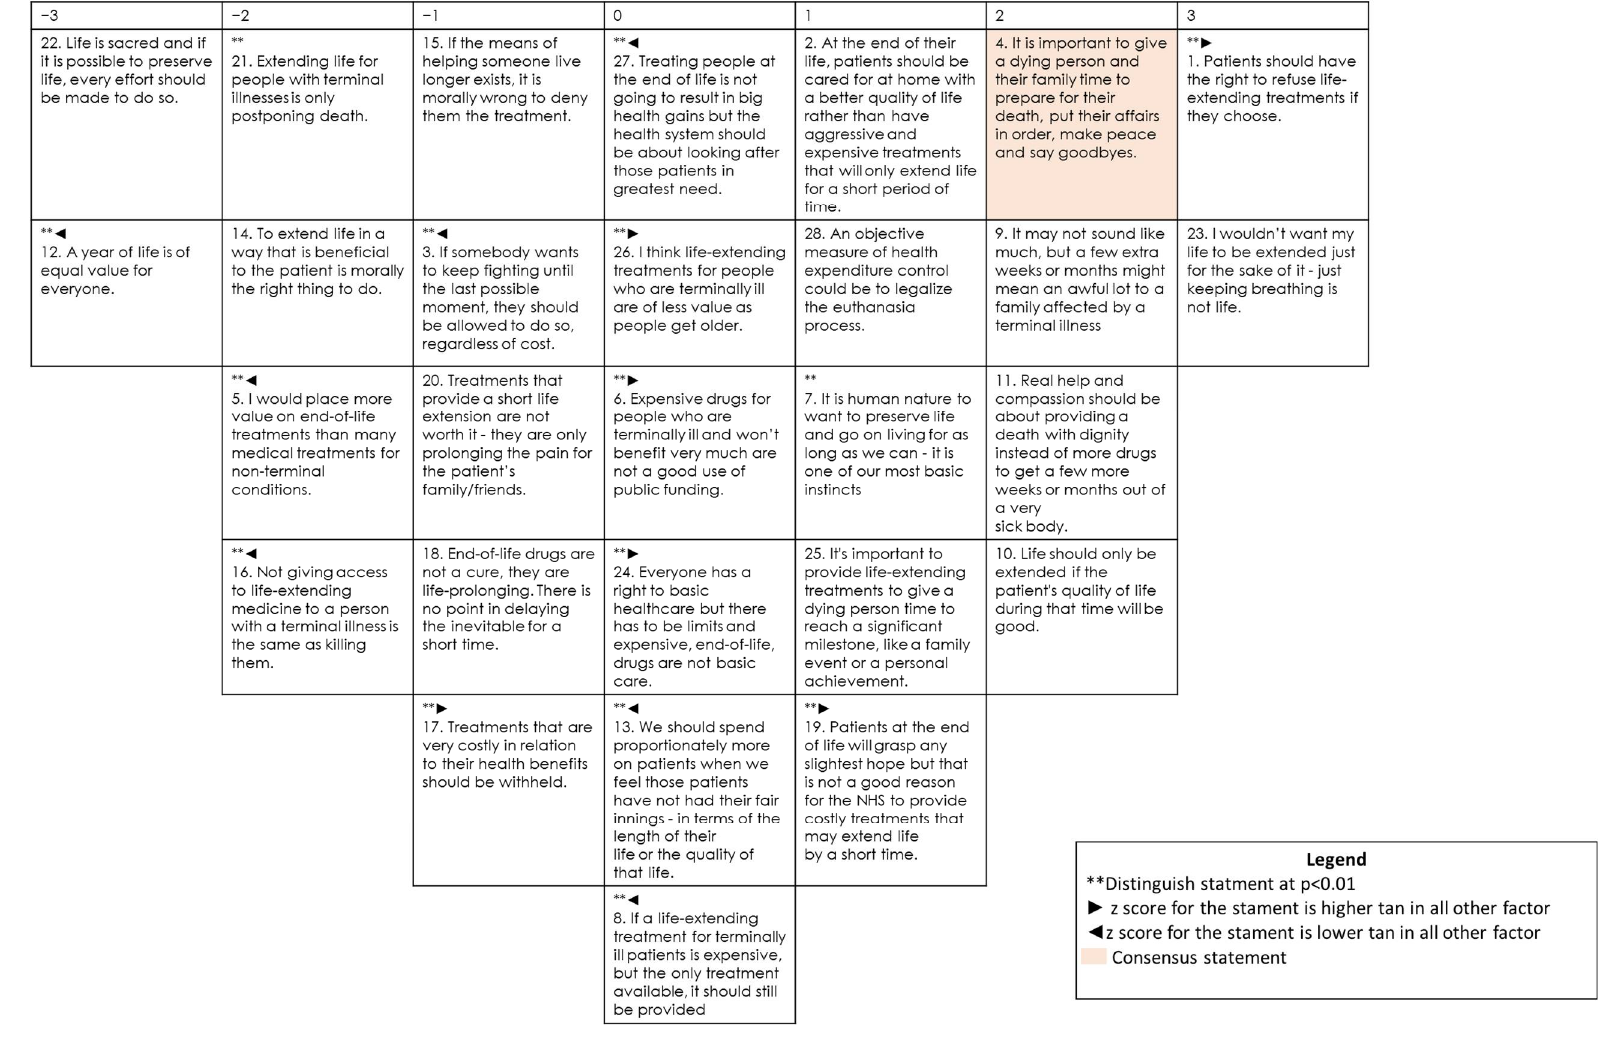
Figure 3. Composite Q sort for factor 3 .